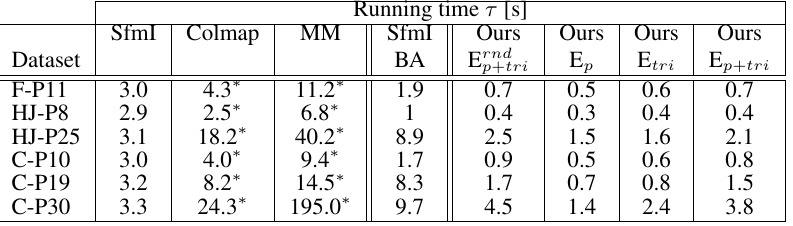
Table 4. Strecha benchmark. Average position error ( err ) w.r.t ground truth for different sequential (Pierrot Deseilligny and Cl´ery, 2011), (Schonberger and Frahm, 2016) SfMs, as well as our approach (Ours). SfmI is the initial solution found with (Wilson and Snavely, 2014) that we relied upon in our BA. The E rnd p + tri corresponds the solution with structure approximated by pairs an triplets with randomly distributed points; a mean value over 1000 repeated calculations is reported; E p , E tri , E p + tri are the solutions where the structure is approximated with 5 points (see Figure 2(d)), and structure is approximated with pairs, triplets and the fusion of both, respectively.